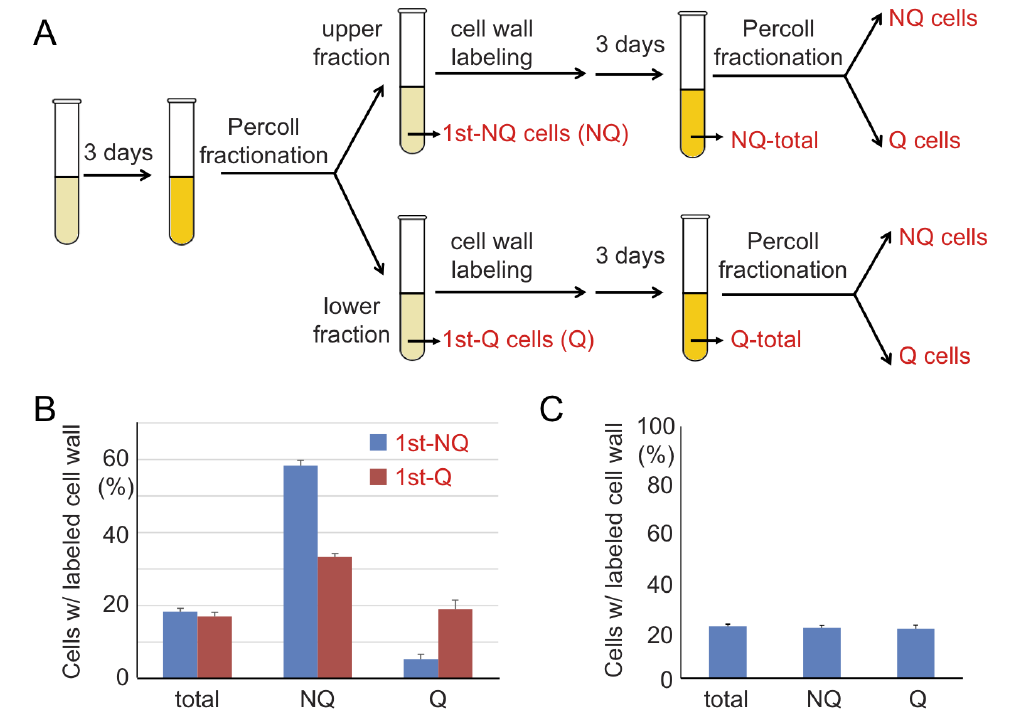
FIGURE 7: The cell fate of NQ cells is mostly irreversible. (A) A schematic diagram of the regrowth experiment. Q and NQ cells from 3-day stationary phase cultures were labeled with NHS-Rhodamine and then allowed to separately regrow for another 3 days. The regrown cul- tures were fractionated again and the cells were analyzed. (B) Most NQ cells from the first fractionation are distributed to the NQ (upper) fractions even after regrowth. The mean percentages of cells with Rhodamine-stained cell walls in total stationary phase cultures (total) and the gradient-isolated fractions (NQ and Q) are shown. (C) Rhodamine staining does not influence cell fate determination. Cells from station- ary phase cultures were stained with NHS-Rhodamine and then mixed with unstained cells from the same culture. The mixed cell cultures were fractionated and the percentages of Rhodamine-stained cells in different fractions were analyzed. In all regrowth experiments, at least 3 repeat experiments were performed and at least 100 cells were counted in each repeat. Error bars represent the standard